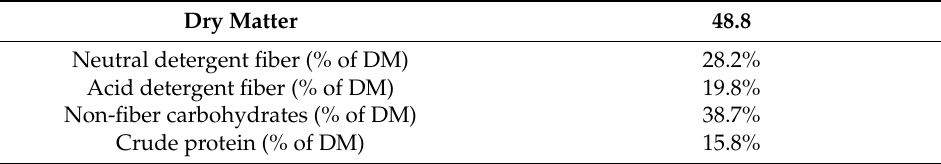
Table 1. The characteristics of total mixed